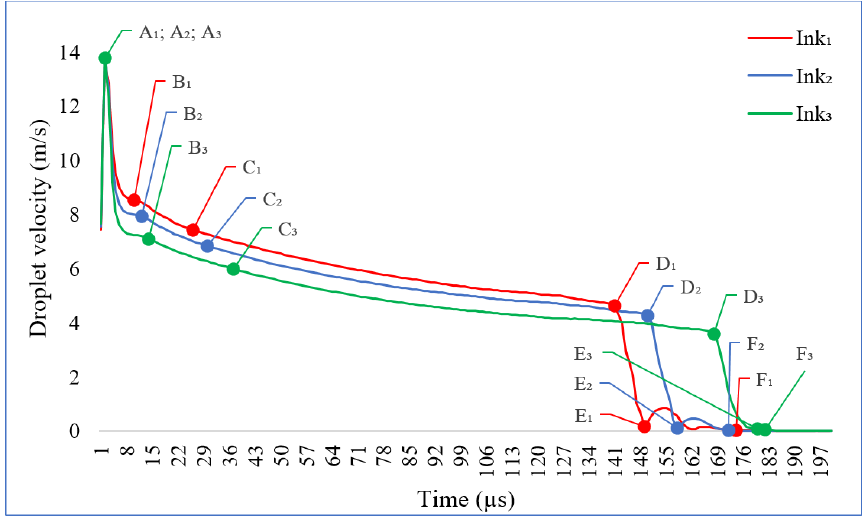
Figure 5. Representation of the droplets (Ink₁, Ink₂, Ink₃) velocity turnover. Velocity versus time. At point A, the droplets of the different inks reach the same maximum velocity at the maximum pressure in the nozzle chamber leading to the ejection of the droplet. The B point corresponds to the droplet thread pulled off from the printhead nozzle—here, dif- ferent inks have different starting velocities for droplet formation—to assuming spherical form at point C where velocities do not change much. least. Final point F represent the droplet in final-stable form which is reached at different times after the ejection: F 1 -174 µ s (from D 1 to F 1 -25 µ s.), F 2 -172 µ s (from D 2 to F 2 -14 µ s), F 3 -181 µ s (from D 3 to F 3 -2 µ s). Droplets from Ink 1 are not so viscous and after the